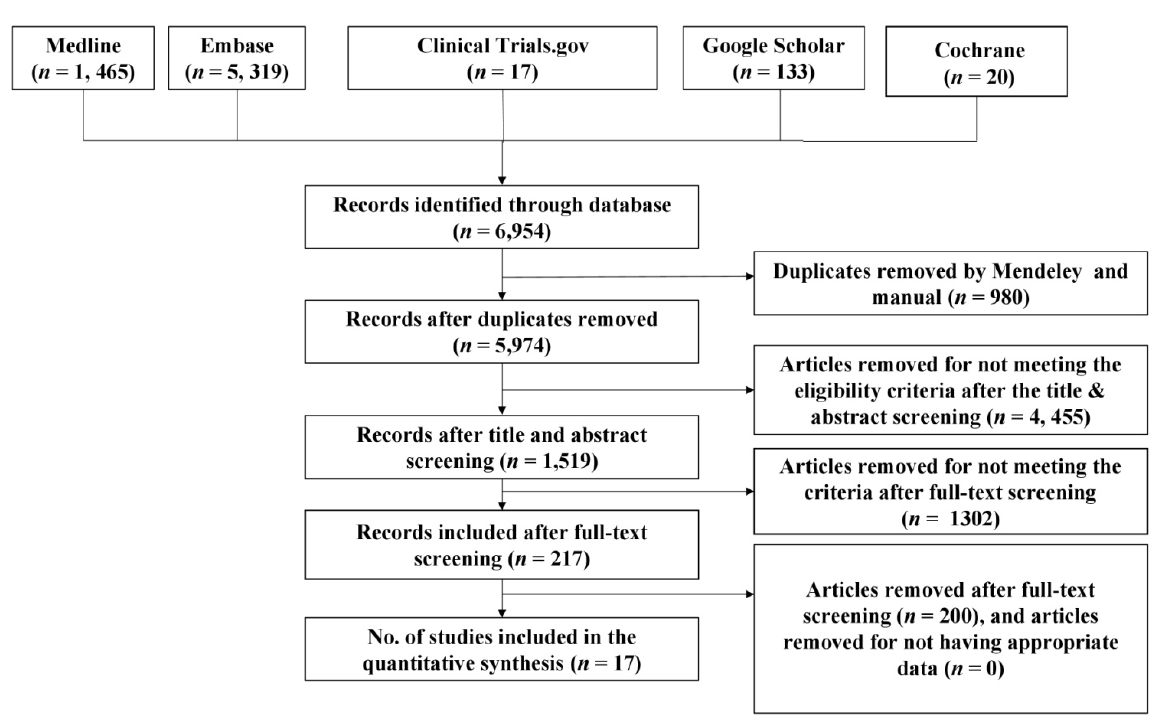
Figure 1. PRISMA flow diagram.